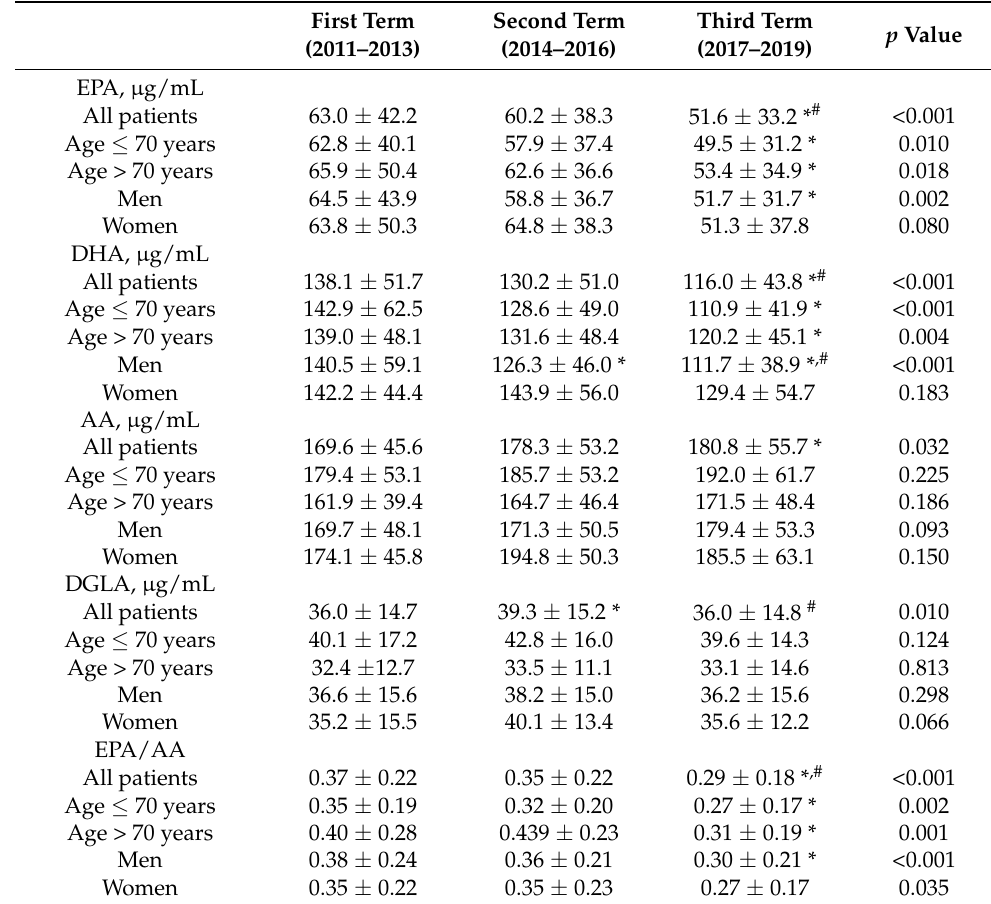
Table 2. Secular trend in polyunsaturated fatty acids in all